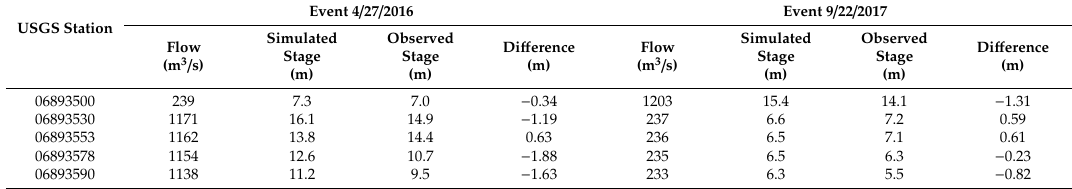
Table 5. HEC-RAS Model Validation for flood events of 27 April 2016 and 22 September